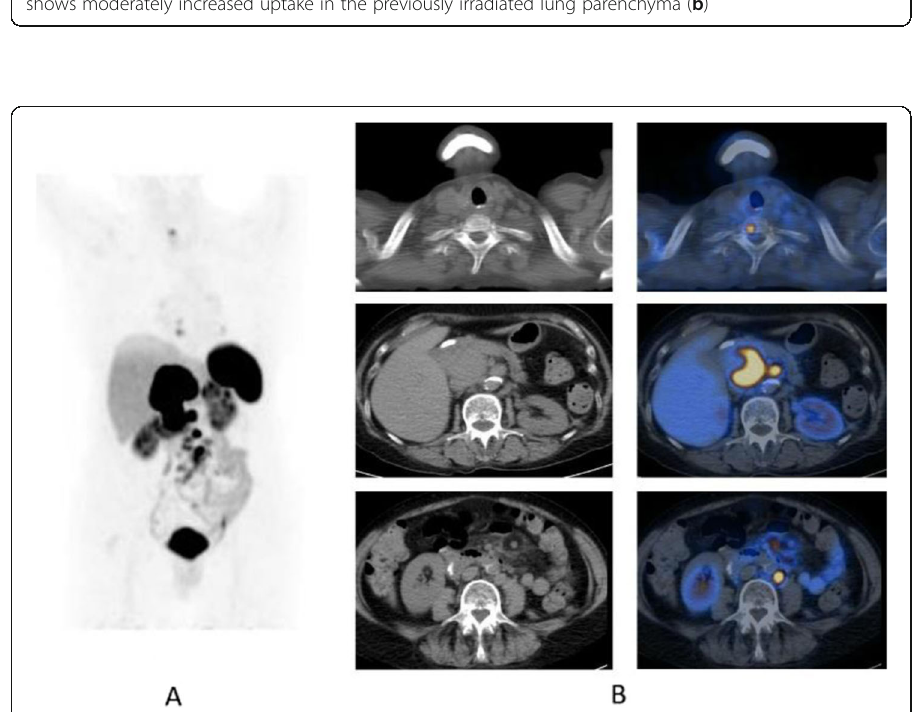
Fig. 59 68 Ga-DOTA peptide, staging NET of the pancreas, sensitivity. Clinical history : 54 y.o. man with known pancreatic NET, candidate for surgery. PET/CT findings : very high uptake in the known pancreatic lesion and as well as in previously unknown lymph nodes and bone lesions ( a MIP, b CT and fused